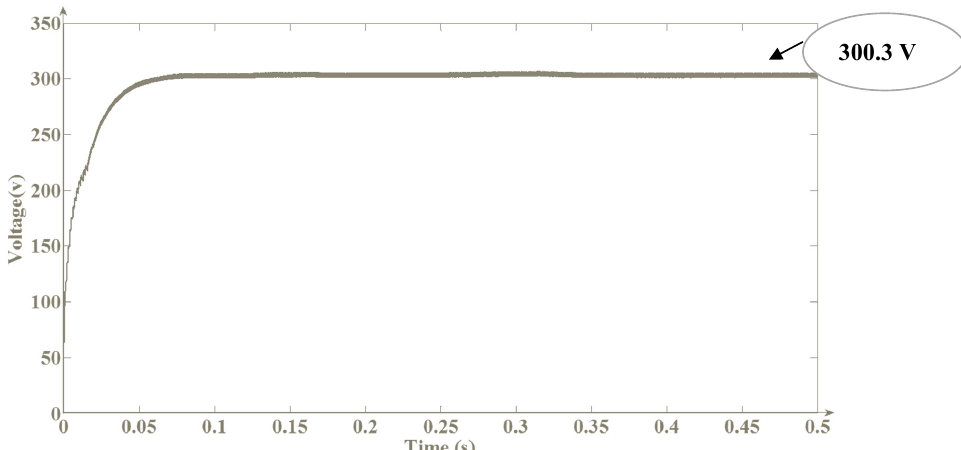
Figure 46. Output voltage waveform for hybrid controller-2-based BDC.